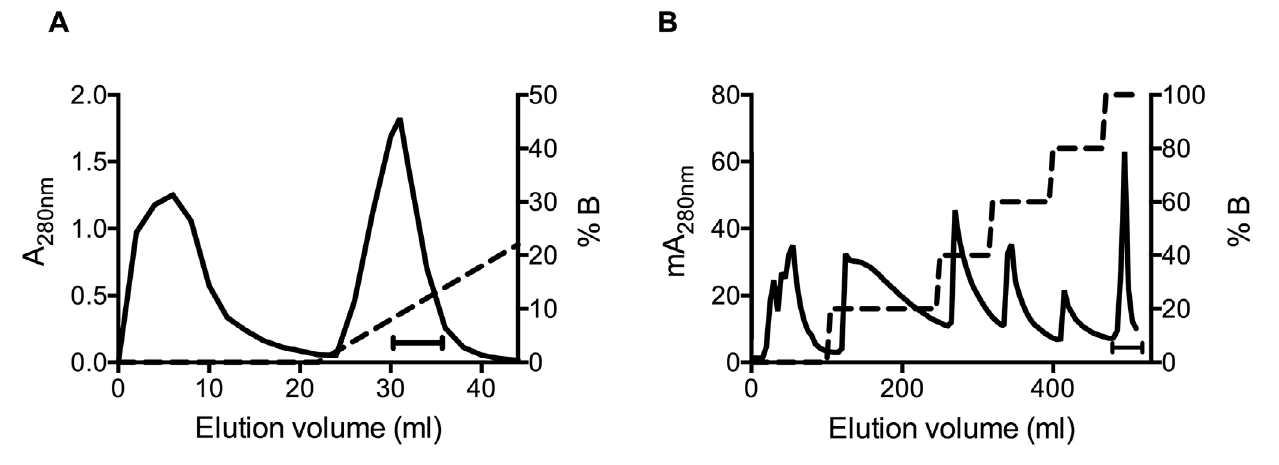
Figure 3. Purification of BcNF from B. constrictor blood plasma. (A) Anion-exchange and (B) hydrophobic interaction chromatograms. Elution gradients are indicated by dotted lines. PLA inhibitor-containing fractions are indicated by horizontal 2